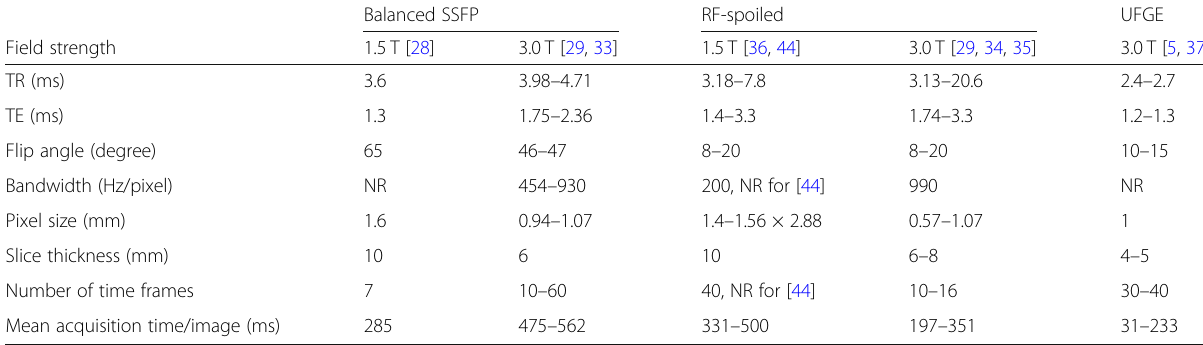
Table 2 Sequence parameters reported in the recent literature for real-time joint dynamic MRI sequences at 1.5 T and 3.0